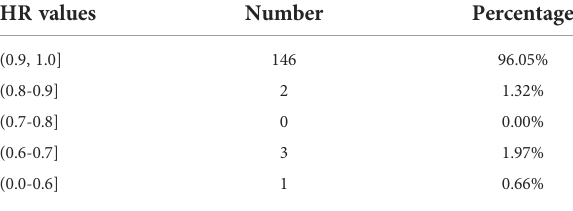
TABLE 4 HR in 152 cases of test